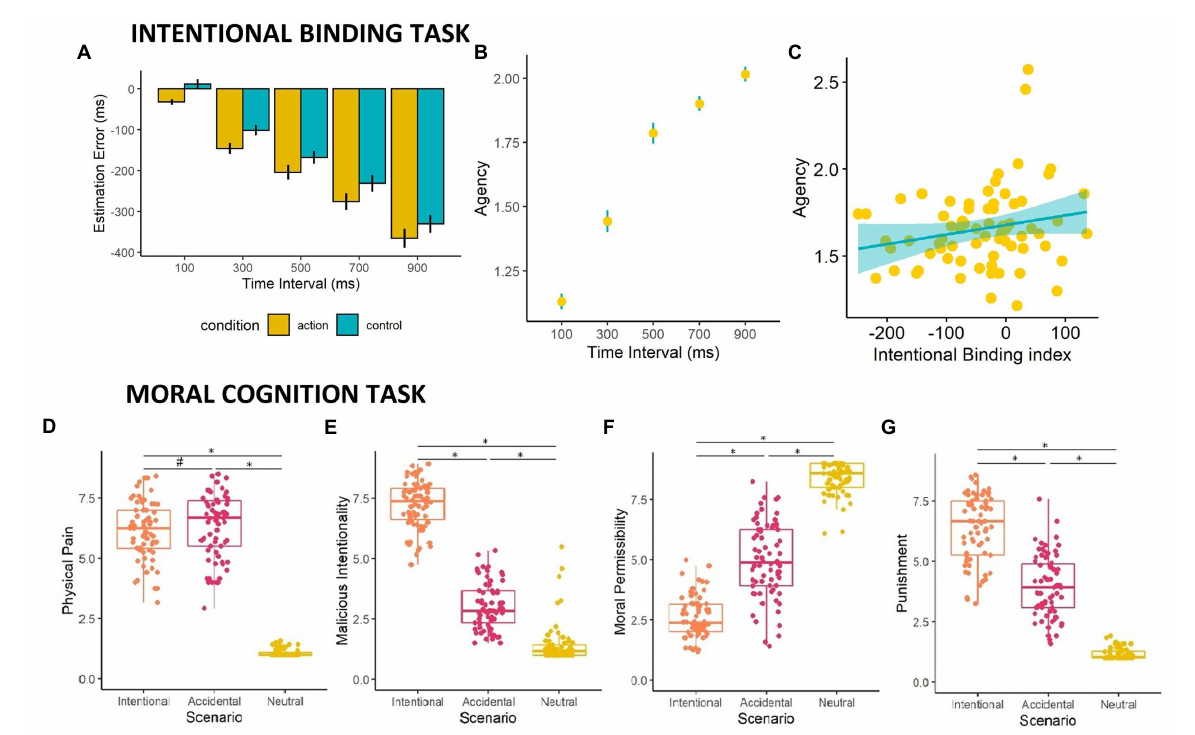
FIGURE 2 Intentional Binding Task & Moral Cognition Task Results. (A) The implicit measure of intentional binding (Estimation Error; y-axis) is presented for the different time intervals (x-axis). (B) The explicit measure of agency (Agency Rating; y-axis) is plotted in relation to the different time Intervals (x-axis). (C) Scatter plot showing the correlation between explicit agency (y-axis) and the Intentional Binding index (x-axis). (D) Box plot showing physical pain ratings. (E) Box plot showing malicious intentionality ratings. (F) Box plot showing moral permissibility rating. (G) Box plot showing punishment ratings. For each graph of the Moral Cognition task (D–G) , the x-axis represents the three different scenarios (Intentional, Accidental, Neutral) while the y-axis depicts the specific rating score. Significance levels are shown by hashes and asterisks ( # p = 0.05, * p <